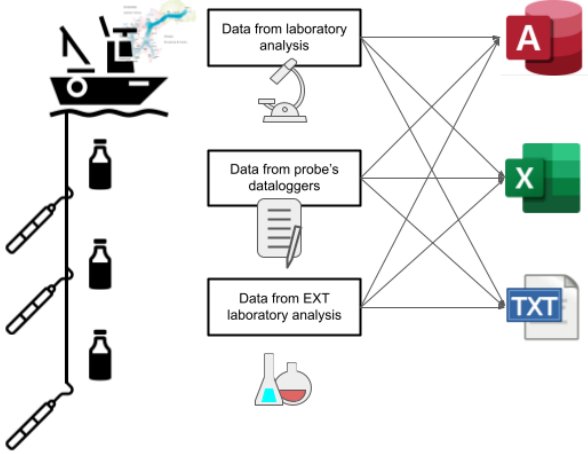
Figure 3. Data formats used to archive the historical data of Lake